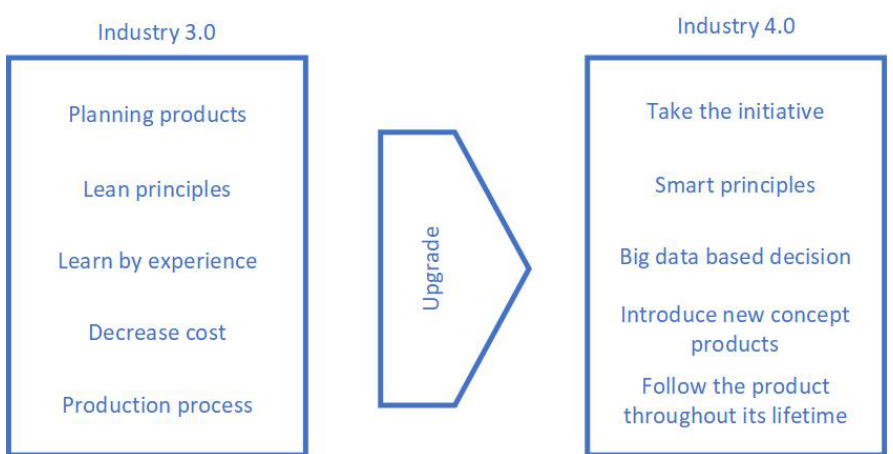
Figure 1. Industry 3.0 vs. Industry 4.0: Industry 4.0 focuses on taking the initiative and following the product throughout its lifetime, often based on informed, data-driven